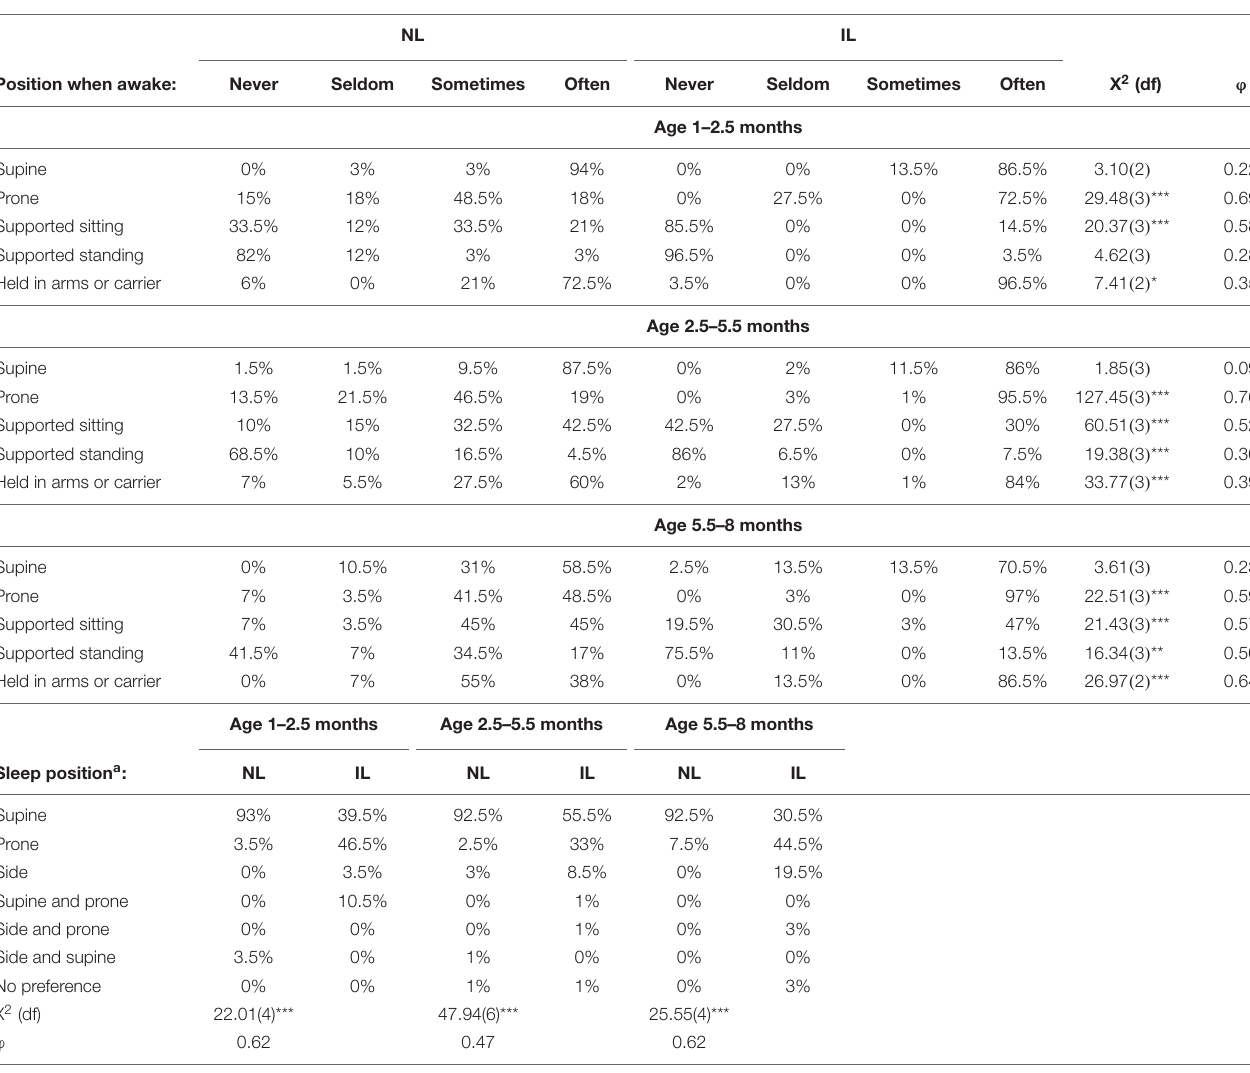
TABLE 5 | Preferred position when awake and during